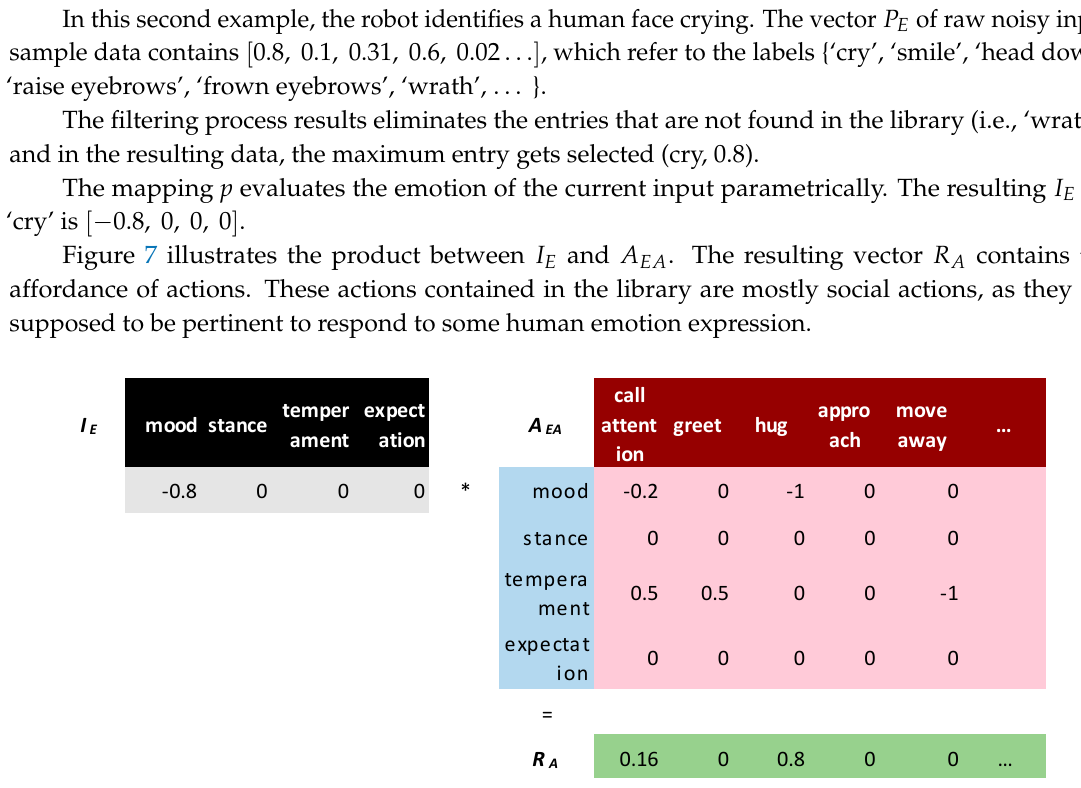
Figure 8. Summary of the object-to-emotion affordance process.